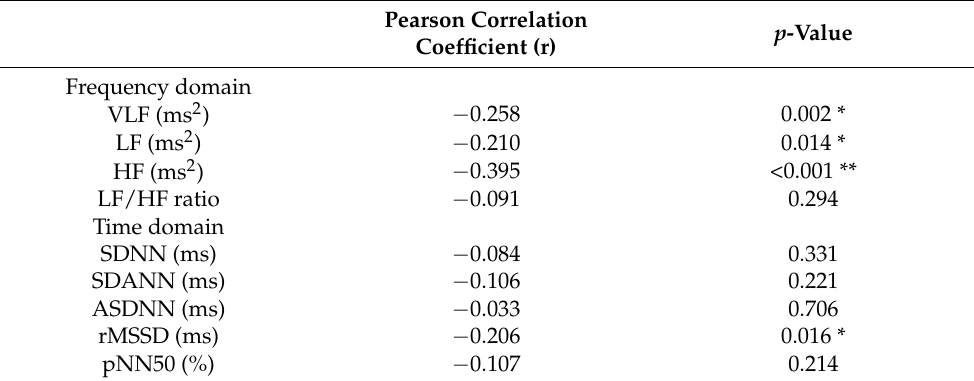
Table 6. Correlation between HRV parameters and Patient Health Questionnaire-15.